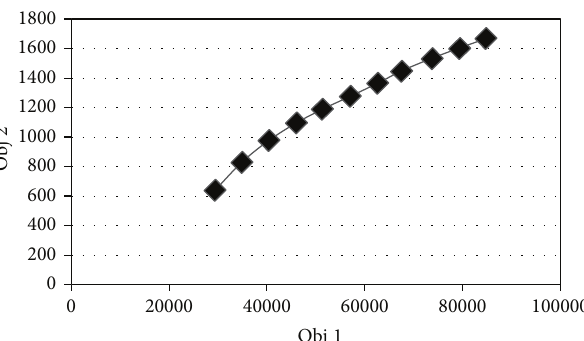
Figure 1: The results obtained by the 𝜀 -constraint method.